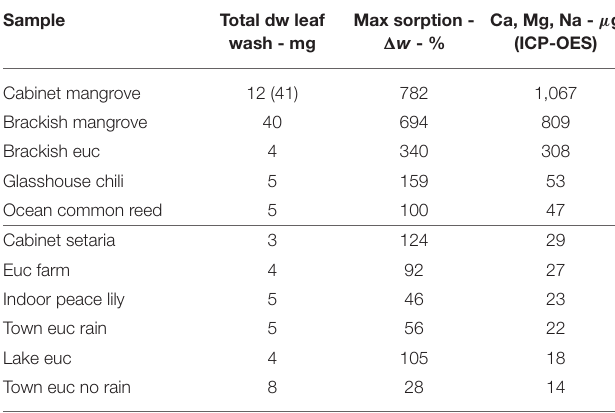
TABLE 4 | Totals of dry weight, maximum sorption and certain ICP-OES weights of leaf wash samples.